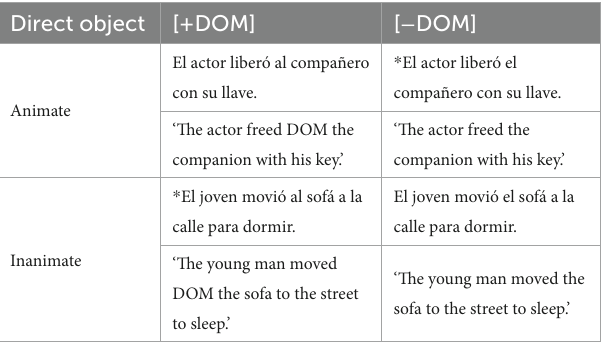
TABLE 6 Sample sentences used in the eye-tracking